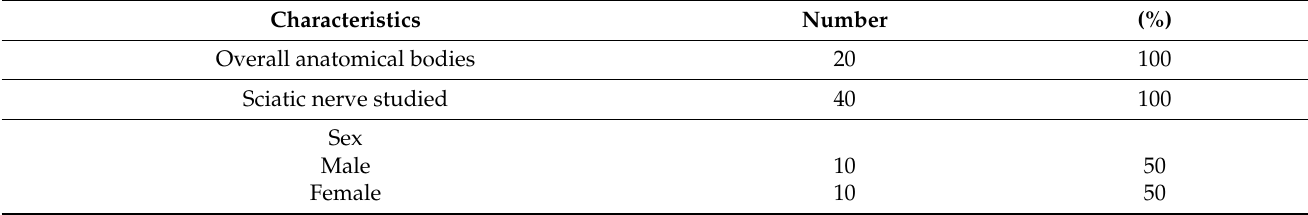
Table 1. Anatomical variations of the SN in relation to the PM and